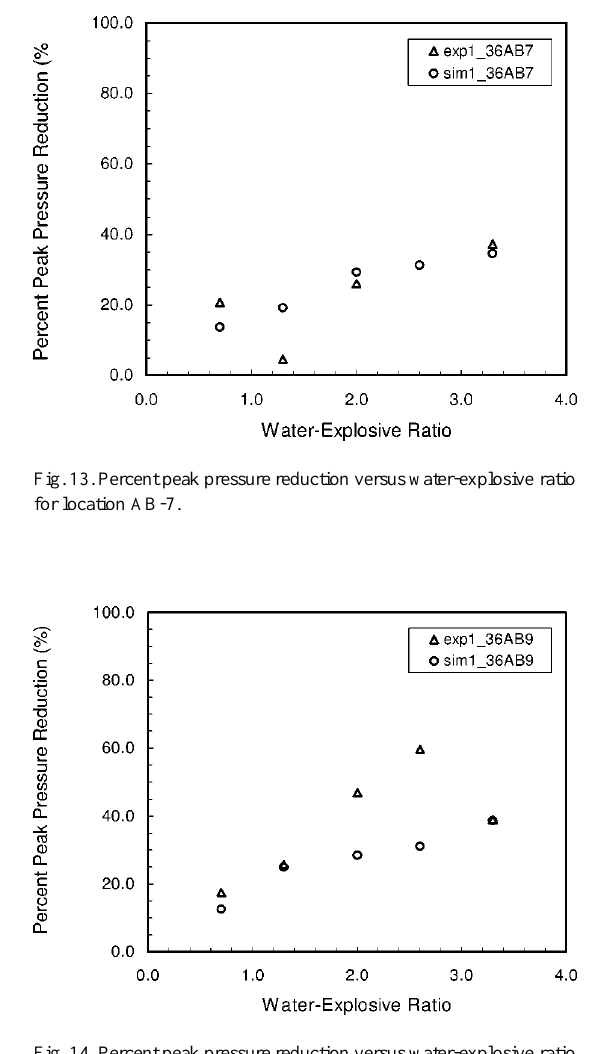
Fig. 14. Percent peak pressure reduction versus water-explosive ratio for location